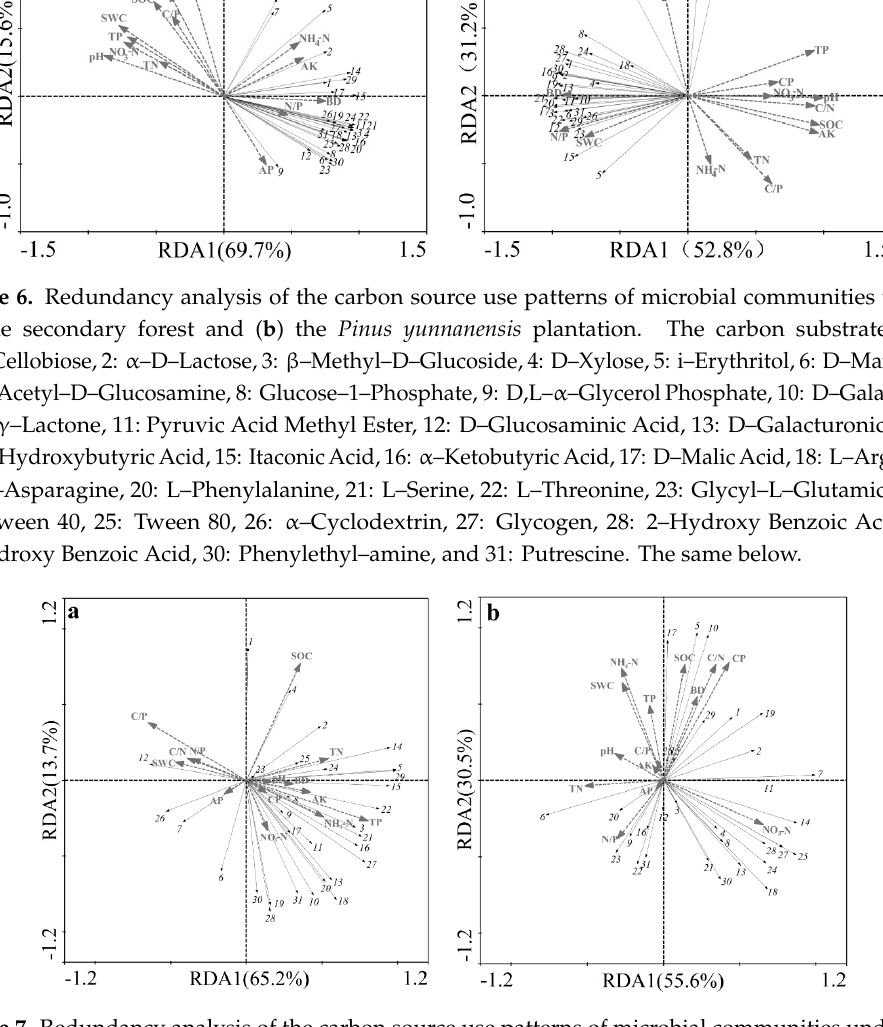
Figure 7. Redundancy analysis of the carbon source use patterns of microbial communities under the ( a ) non-karst area and ( b ) karst ( a ) non-karst area and ( b ) karst area.